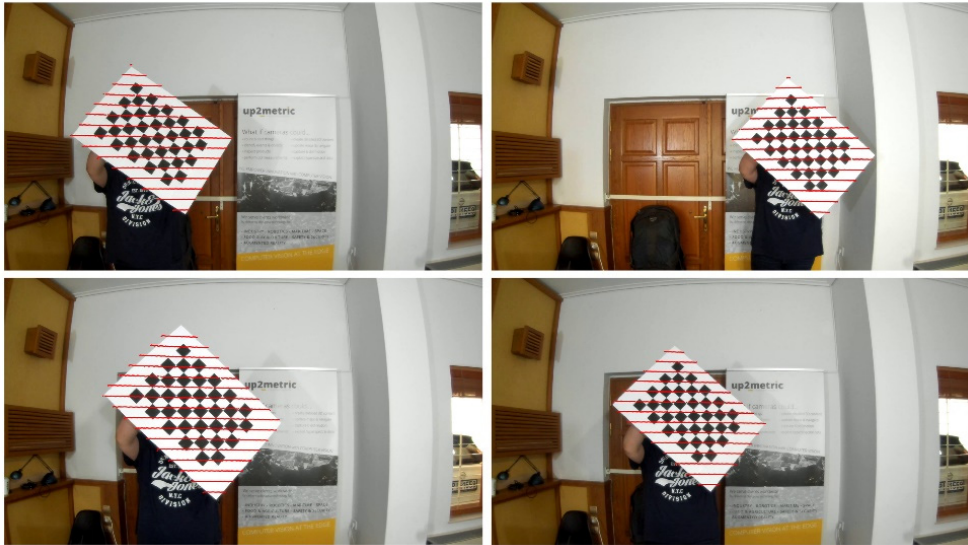
Figure 9. The Lidar points corresponding to the chessboard are displayed on four calibration frames using the estimated extrinsic calibration from Zhou’s method.